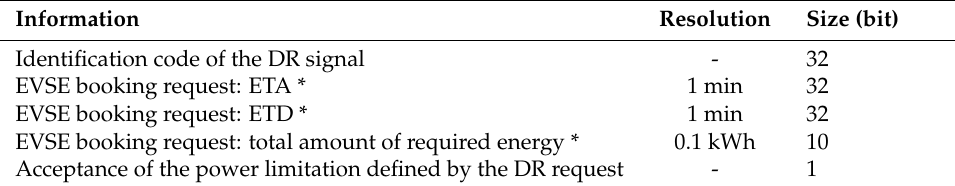
Table 5. List of information packed into each data sample transferred by the EV to the EV-MSP as reply to V2G DR requests. EV: Electric Vehicle, EV-MSP: EV Mobile Service Provider, V2G: Vehicle-to-Grid, DR: Demand Response, ETA: Estimated Time of Arrival, ETD: Estimated Time of Departure. Information Resolution Size (bit) Identification code of the DR signal -